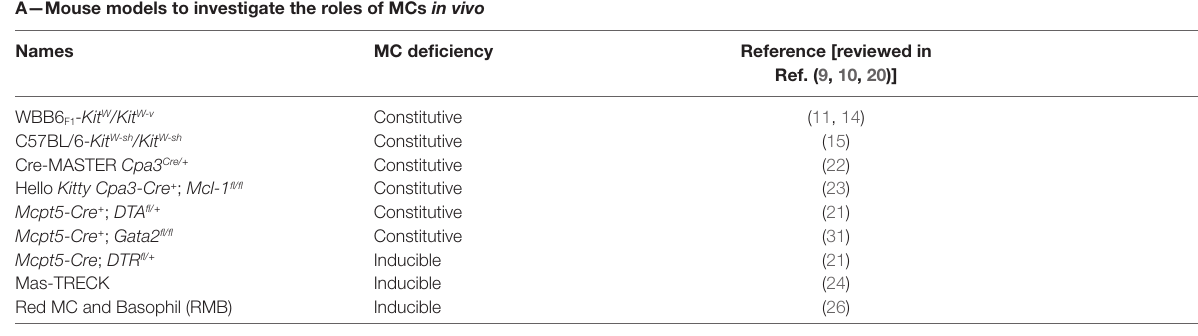
TABLe 1 | Genetic and imaging approaches to study mast cell (MC) functions in vivo . A—Mouse models to investigate the roles of MCs in vivo